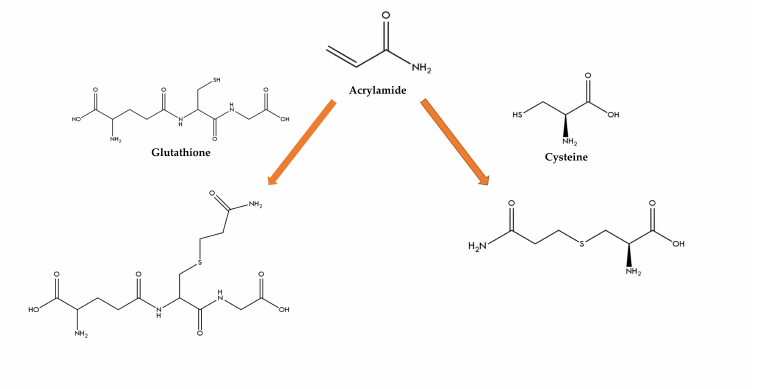
Figure 1. Scheme of the Michael addition reaction for ACR with L-GSH and L-Cys.